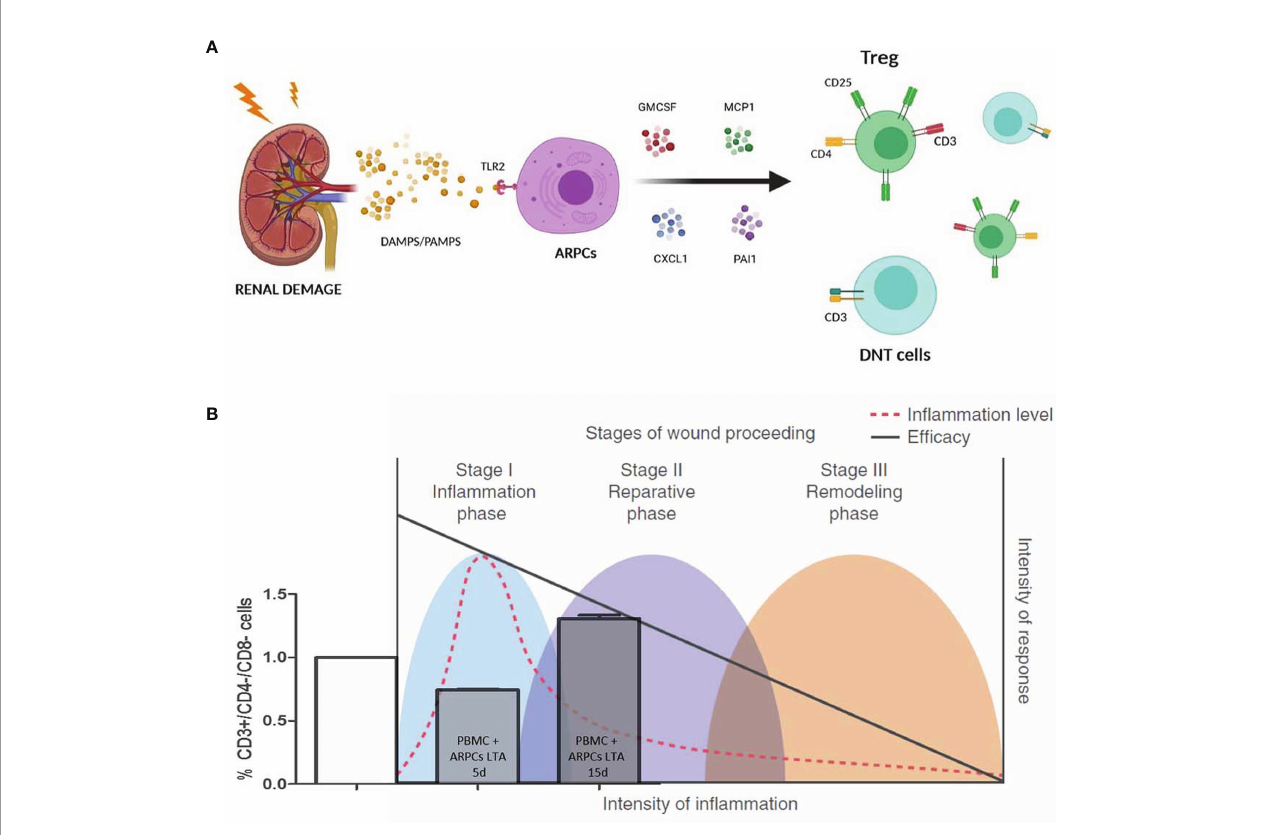
FIGURE 2 | (A) Following a renal damage ARPCs detect the insult by the binding of Pathogen Associated Molecular Patterns (PAMPs), such as lipoteichoic acid (LTA), or damage-associated molecular patterns (DAMPs) on the Toll-like receptor 2 (TLR2). ARPCs then inhibhit the Treg and the double negative (DN) T cells through paracrine mediators as PAI1, CXCL1, GM-CSF, and MCP1 to favor the initial phase of in fl ammation. (B) ARPCs can mediate immunomodulation and affect in fl ammatory state. The physiological response to tissue damage can be divided into three phases: in fl ammatory, reparative, and remodeling. During this process, in fl ammatory status (de fi ned as the types and concentrations of cytokines and cells of the immune system present) changes considerably: proin fl ammatory in fl uences (red dashed line) are dominant in the in fl ammatory, infection- fi ghting phase and diminish in the reparative and remodeling phases that follow, which allows wound healing. In the context of the intensity of the immune response (right vertical axis), the in fl ammatory response (red dashed line) fl uctuates during the wound-healing process. Such changes in in fl ammation substantially alter the effects of mesenchymal stem cells (MSC)-meditated immunomodulation, which results in a variable correlation between the intensity of in fl ammation and ef fi cacy of MSC treatment (solid black line). Such changes in in fl ammation are also affected by ARPC-meditated immunomodulation. ARPCs cause DN T cell decrease at the initial phase, promoting in fl ammation, and DN T cell increase in the late in fl ammation stages, favoring the in fl ammation